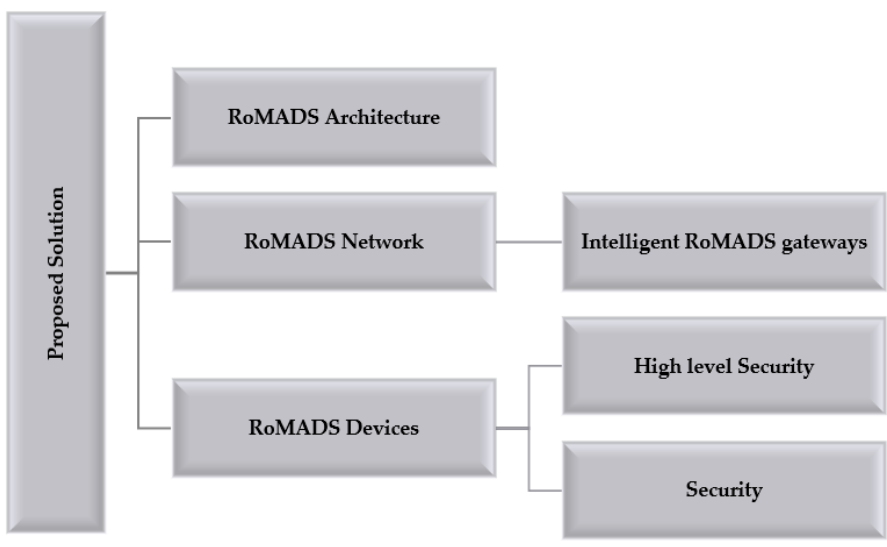
Figure 11. Proposed Solution